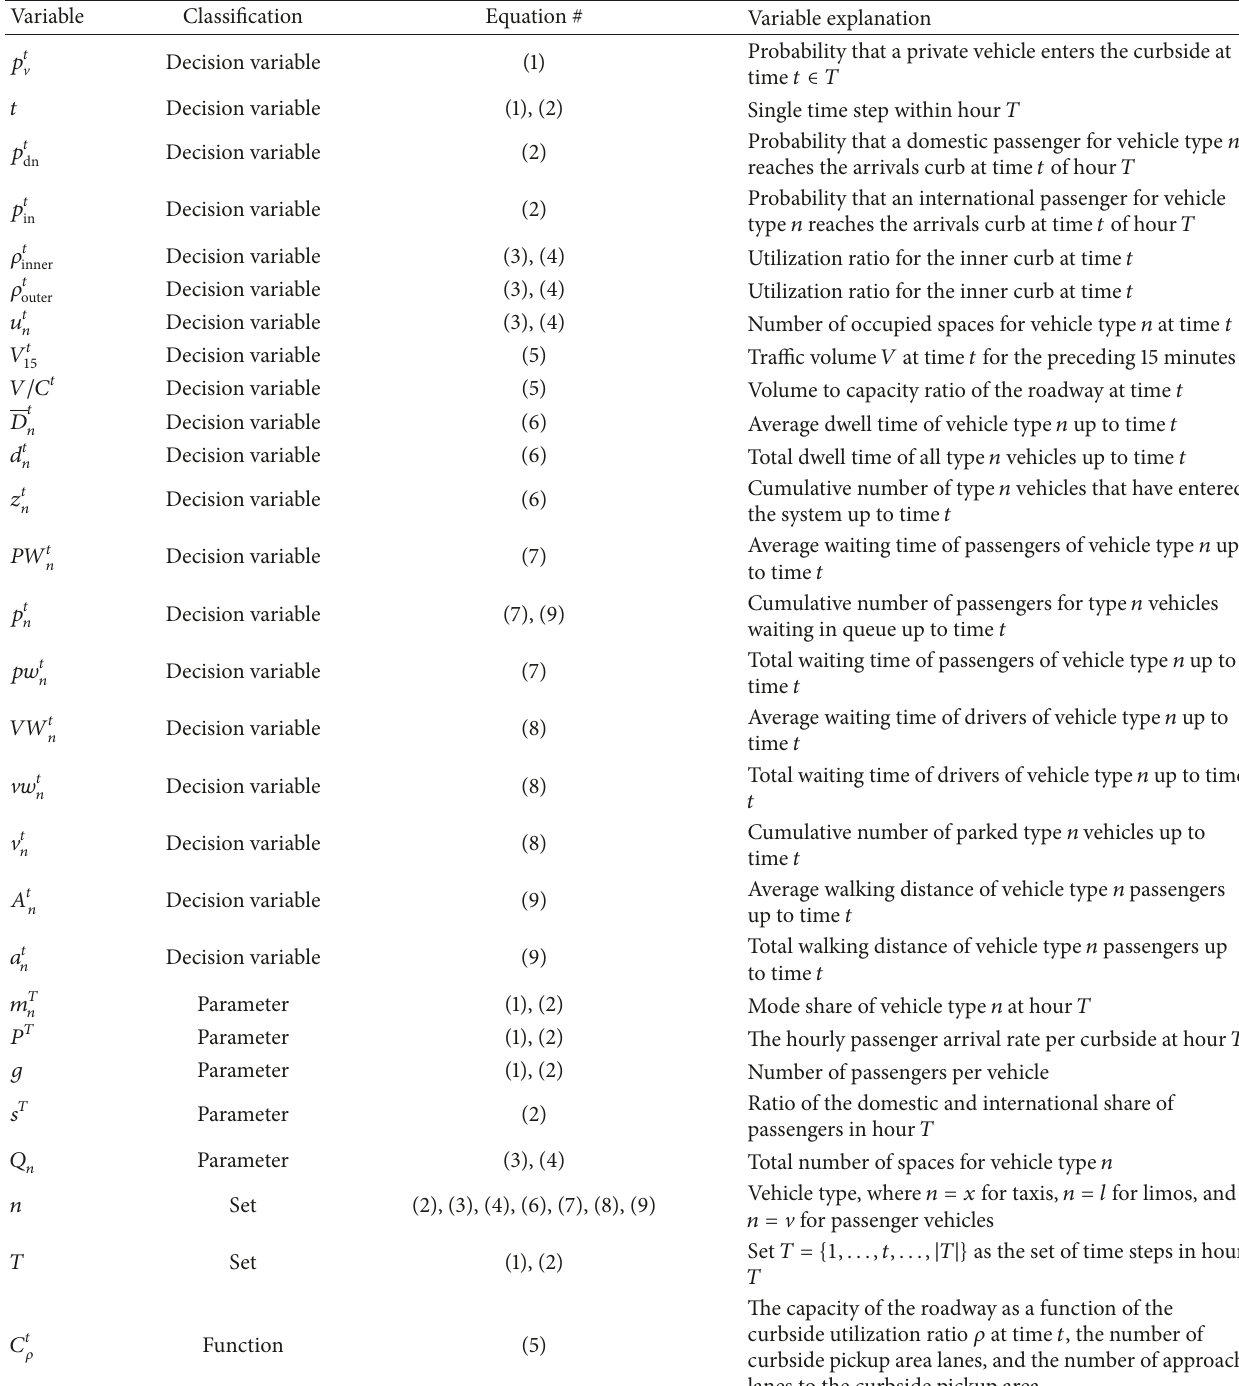
Table 1: Explanation of equation